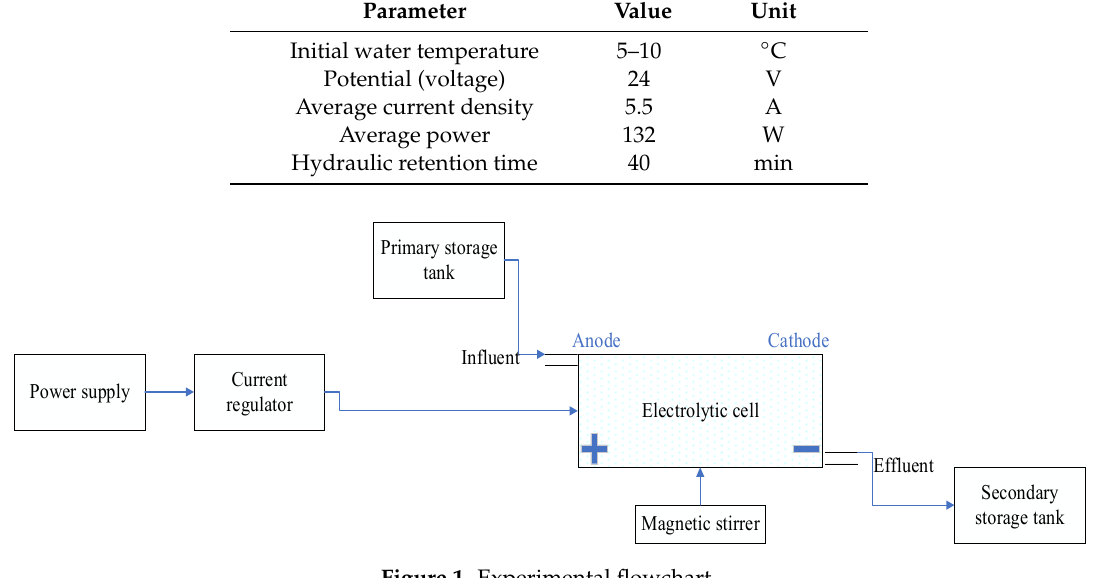
Figure 1. Experimental flowchart.